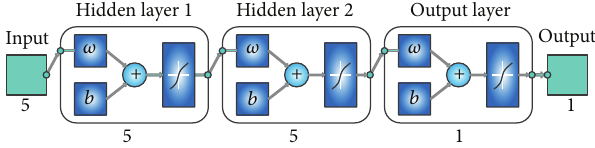
Figure 7: The structure of RS-BPNN